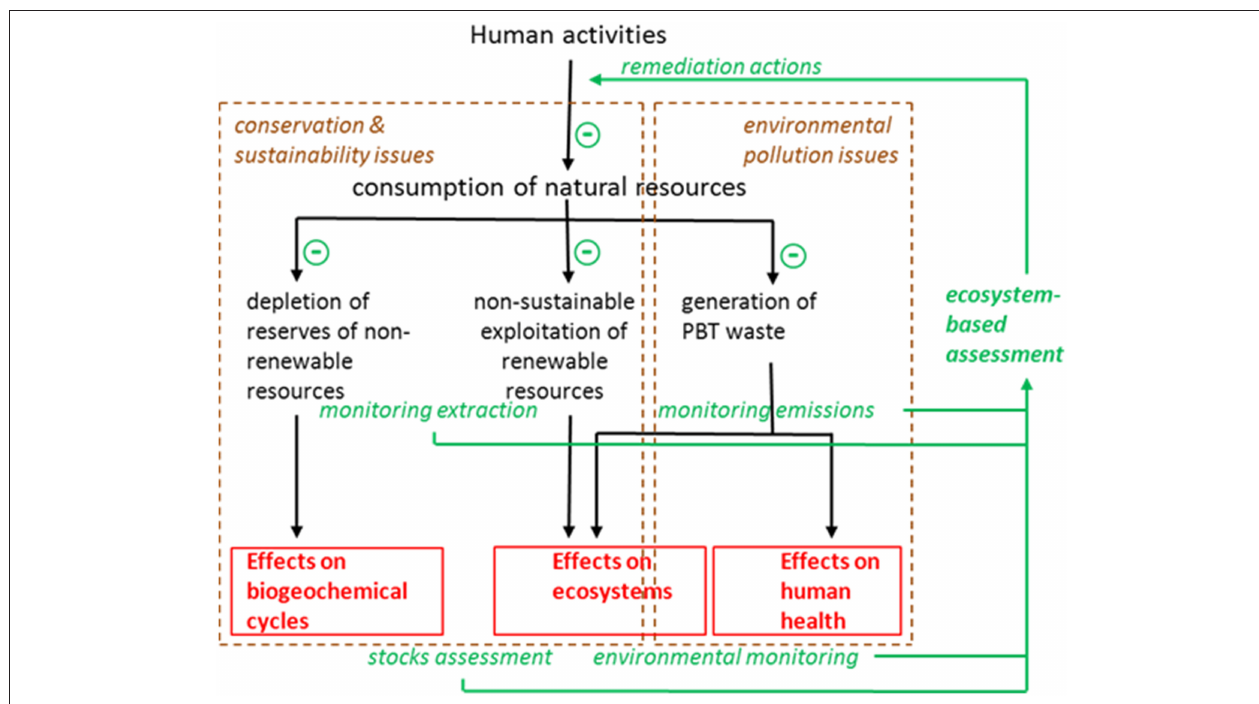
FIGURE 1 | Scheme of a holistic ecosystem-based assessment (EBA) intended to manage the environment in order to avoid depletion of non-renewable resources, non-sustainable exploitation of renewable resources, and environmental pollution. Notice that remedial actions are planned according to the information gathered in the monitoring programs that include both monitoring the levels of pressures (extractions, emissions; i.e., causes) and monitoring the levels of impact (effects) on ecosystem structure, functioning, and human